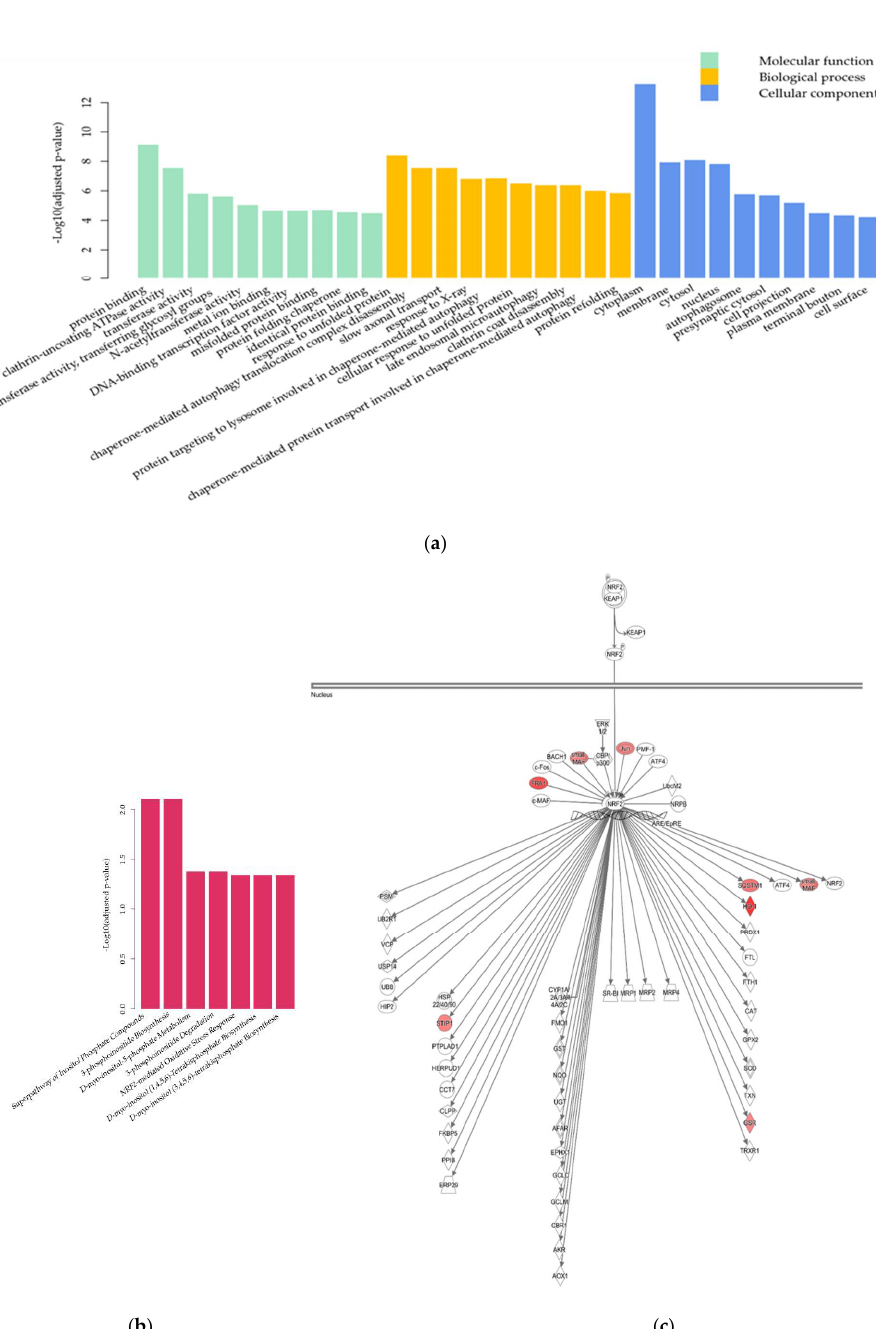
Figure 5. Gene Ontology (GO) enrichment analysis and pathway analysis of differentially expressed genes (DEGs) upon edaravone treatment of differentiated neuronal cells under the neurotoxic con- dition induced by TDP-43 and ethacrynic acid. ( a ) The top 10 significantly enriched GO terms according to a hypergeometric test p -value adjusted with the Benjamini–Hochberg (BH) procedure. Green bars: GO terms in molecular function category; orange bars: GO terms in biological process category; blue bars: GO terms in cellular component category. ( b ) Significant pathways (BH-adjusted p -value ≤ 0.05). ( c ) The illustration of the Nrf2-mediated oxidative stress response pathway is generated using the Ingenuity Pathway Analysis software. Red objects represent genes that were upregulated with the addition of edaravone to differentiated neuronal cells under the neurotoxic condition induced by TDP-43 and ethacrynic